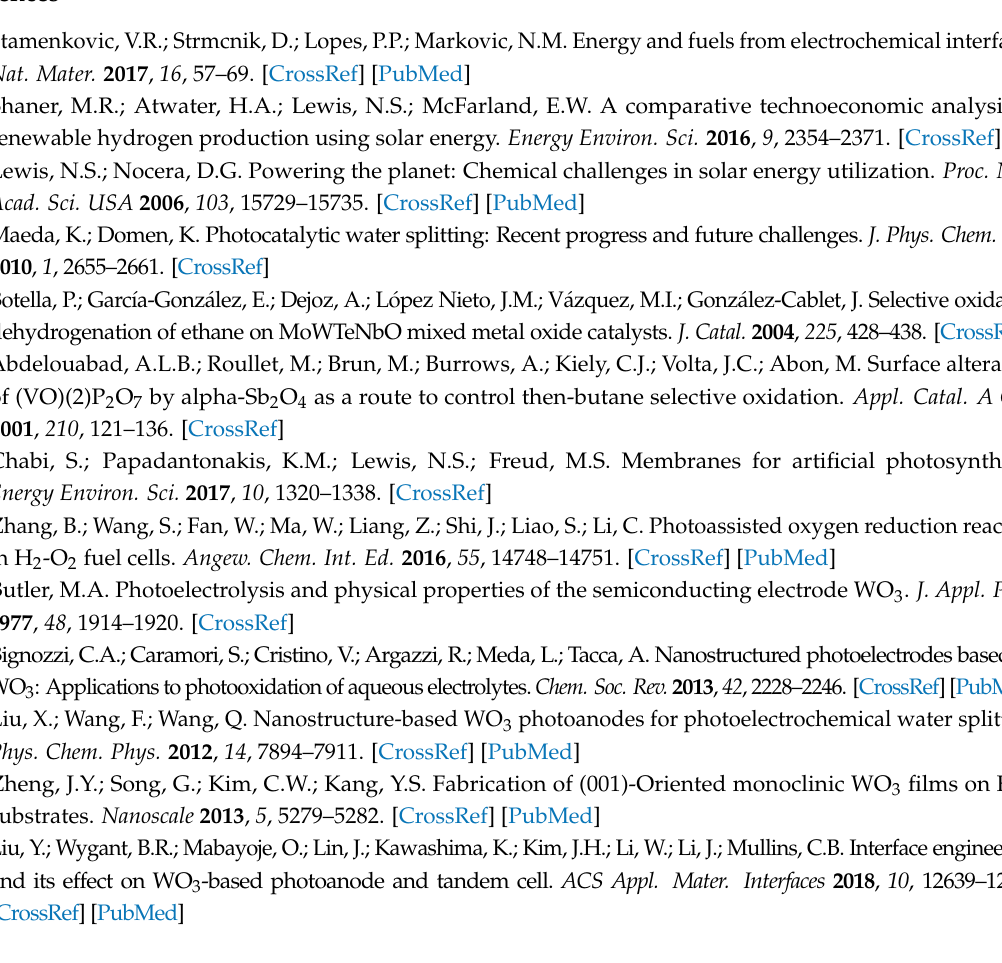
Figure S1: X-Ray diffraction patterns of ( A ) m-WO 3 , NC and the m-WO 3 /carbon mixtures; ( B ) h-WO 3 , NC and the h-W/NC50, diffractograms are shifted for clarity; red bars indicate the standard pattern (JPDS-01-083-0950 and JCPDS-01-075-2187 corresponding to monoclinic and hexagonal lattice, respectively). Absorbance spectra of ( C ) m-WO 3 and the corresponding m-WO 3 /carbon mixtures and ( D ) h-WO 3 and h W/NC50; Figure S2: X-Ray diffraction patterns of h-WO 3 with increasing the calcination temperature; dots indicate the standard patterns corresponding to the hexagonal and monoclinic lattices; Figure S3: Nitrogen adsorption isotherms at − 196 ◦ C performed for the nanonoporous carbon and the semiconductor/carbon mixtures analysed (close symbols represent adsorption; empty symbols represent desorption); Figure S4: Cyclic voltammograms recorded at 20 mV/s of WO 3 and WO 3 /carbon electrodes under (A–C) dark conditions and (D–F) and square-wave light perturbation at 371 nm (black line) for selected electrodes: (D) m-WO 3 , (E) m-W/NC20 and (F) h-WO 3 . Potentials are expressed vs. NHE; Figure S5: Evolution of the open-circuit potential (vs. Ag/AgCl) of ( A ) h-WO 3 and ( B ) m-WO 3 electrodes under illumination at 371 nm (photon flux of 3.4 × 10 14 cm − 2 s − 1 ); Figure S6: Mott-Schottky plots of WO 3 at 3.1 kHz under dark conditions in 0.5 M Na 2 SO 4 pH 1.3; Figure S7: Consecutive transient photocurrent responses of m-W/NC10 electrode at 0.5 V vs. Ag/AgCl (left). Cyclic voltammetry of m-W fresh and after irradiation (right); Table S1: Main textural parameters of the semiconductors and the semiconductor/carbon mixtures obtained from the equilibrium nitrogen adsorption/desorption isotherms at − 196 ◦ C and surface